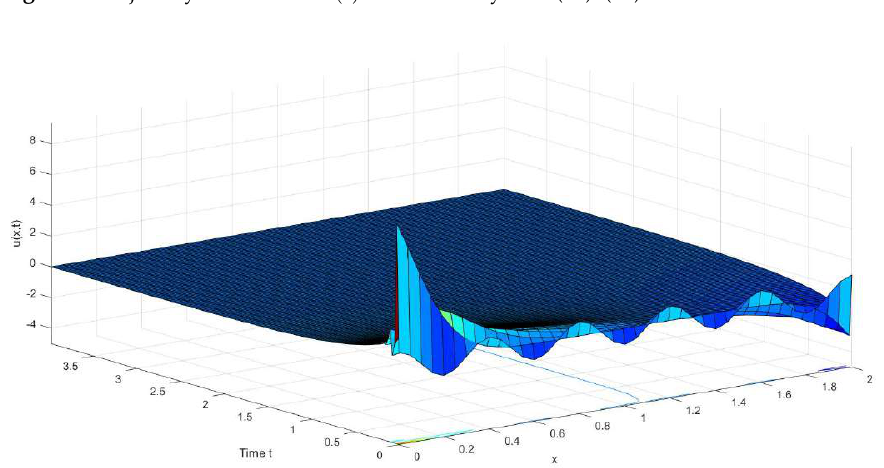
Figure 3. Trajectory of the state u ( x , t ) solution of System